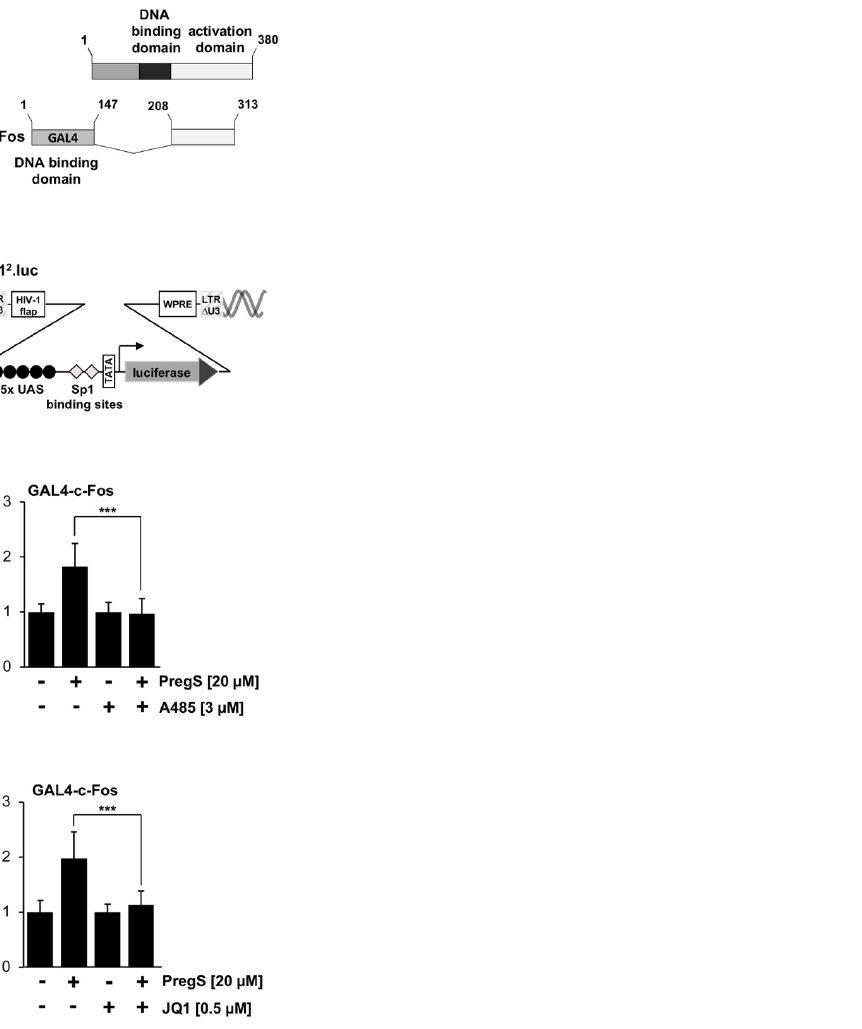
Figure 4. Pharmacological inhibition of CBP/p300 and BET proteins attenuates TRPM3-induced up- regulation of the transcriptional activation potential of c-Fos. ( A ) The modular structure of the GAL4-c-Fos fusion protein. ( B ) Provirus that encodes the GAL4-responsive reporter gene UAS 5 Sp1 2 .luc. ( C , D ) T-REx-TRPM3 cells were infected with a UAS 5 Sp1 2 .luc containing lentivirus. T- REx-TRPM3 cells were infected with a second lentivirus that encoded for the GAL4-c-Fos protein. The cells were maintained in the serum-reduced medium in the presence of tetracycline for 24 h. T- REx-TRPM3 cells were stimulated with pregnenolone sulfate (PregS, 20 μ M) for 24 h in the presence or absence of A485 (3 μ M) ( C ), or JQ1 (0.5 μ M) ( D ). Cells were harvested and analyzed as described in the legend to Figure 2 (( C ), n = 6; ( D ), n = 3; *** p < 0.001).